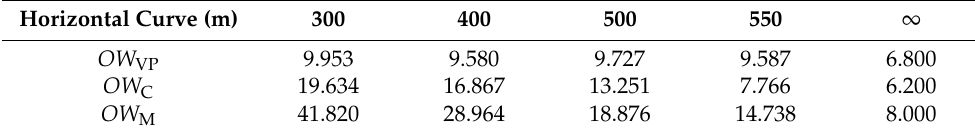
Table 6. Objective workload over different radii.